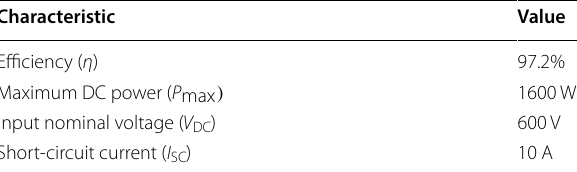
Table 26 Specifications of the inverter, Sunny Boy 1.5